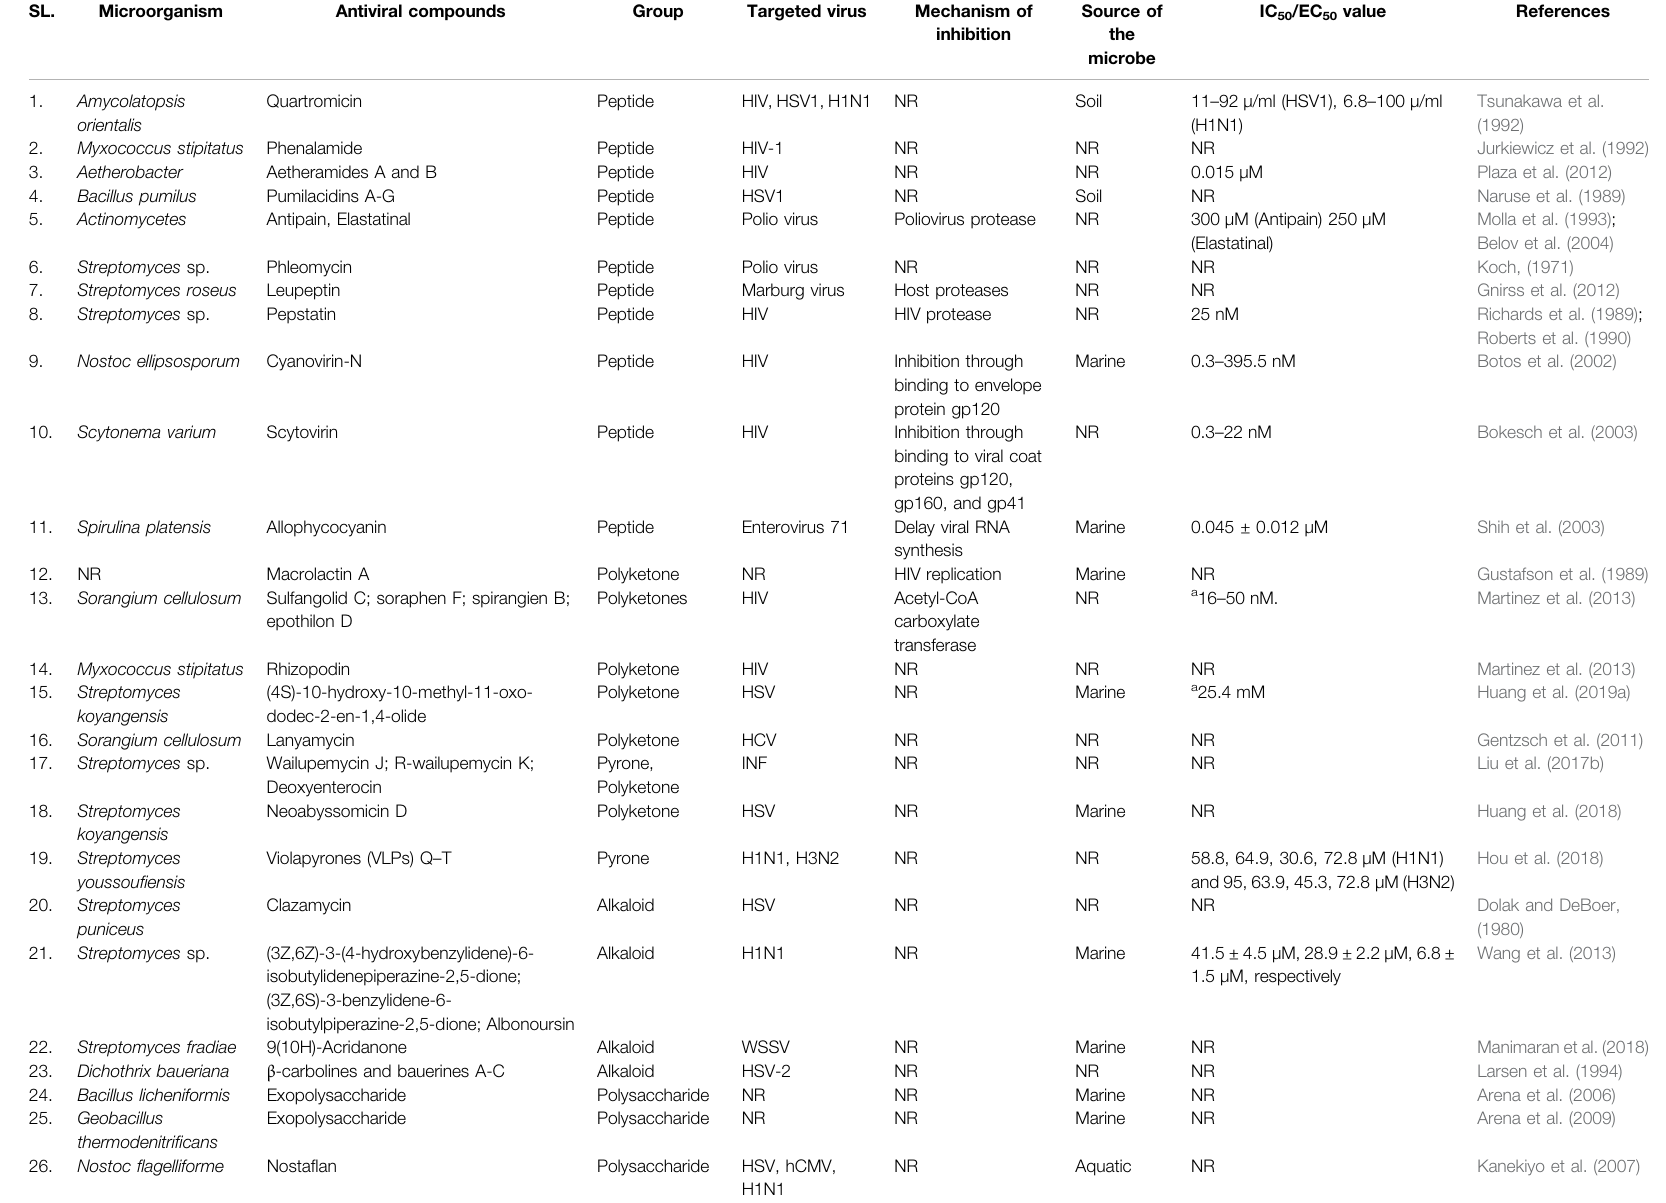
TABLE 2 | Antiviral bioactive compounds isolated from bacteria and cyanobacteria.